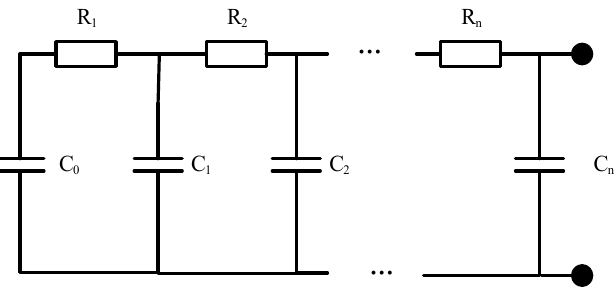
Figure 6. Transmission line model.